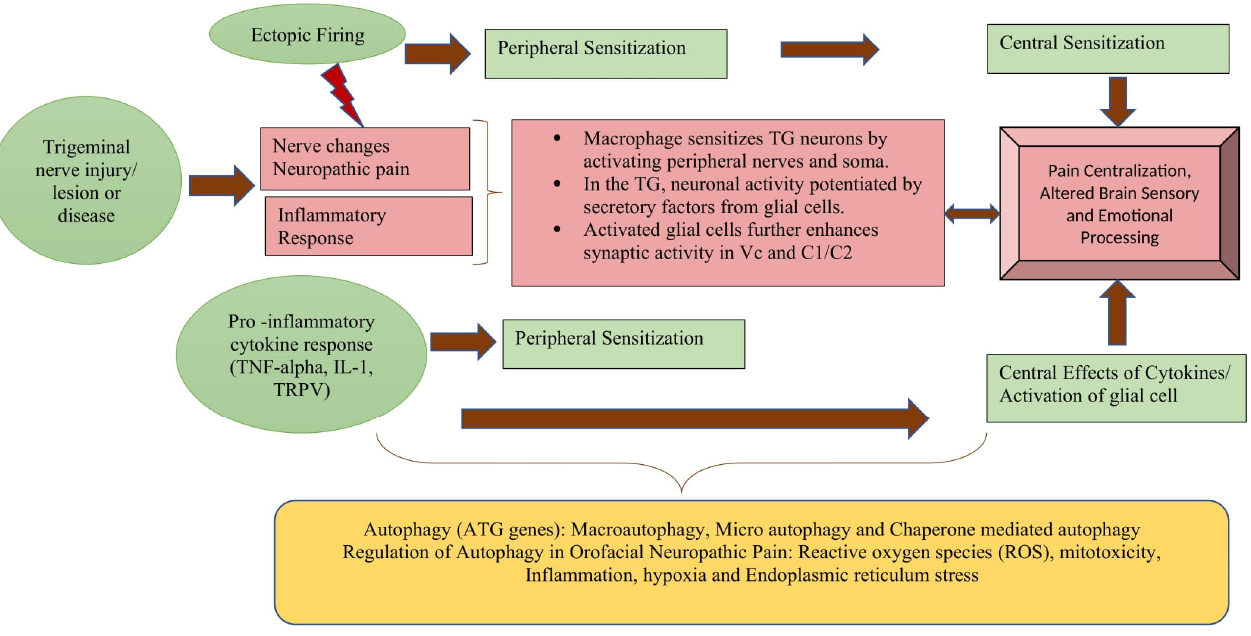
Figure 2. Role of Autophagy in pathogenesis of Neuropathic